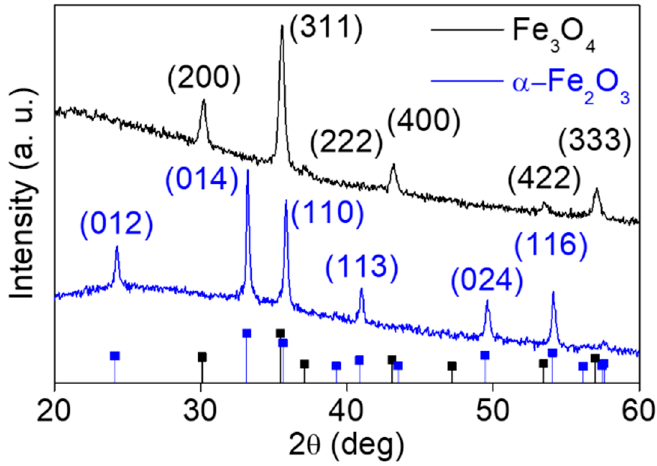
Figure 1. X-ray diffraction (XRD) pattern of as-synthesized ( α -Fe 2 O 3 ) and reduced (Fe 3 O 4 ) nanorings after 5 h of hydrothermal reaction. The lower patterns with blue and black squares are the JCPDS data for bulk α -Fe 2 O 3 and Fe 3 O 4 , respectively [21,27,28].